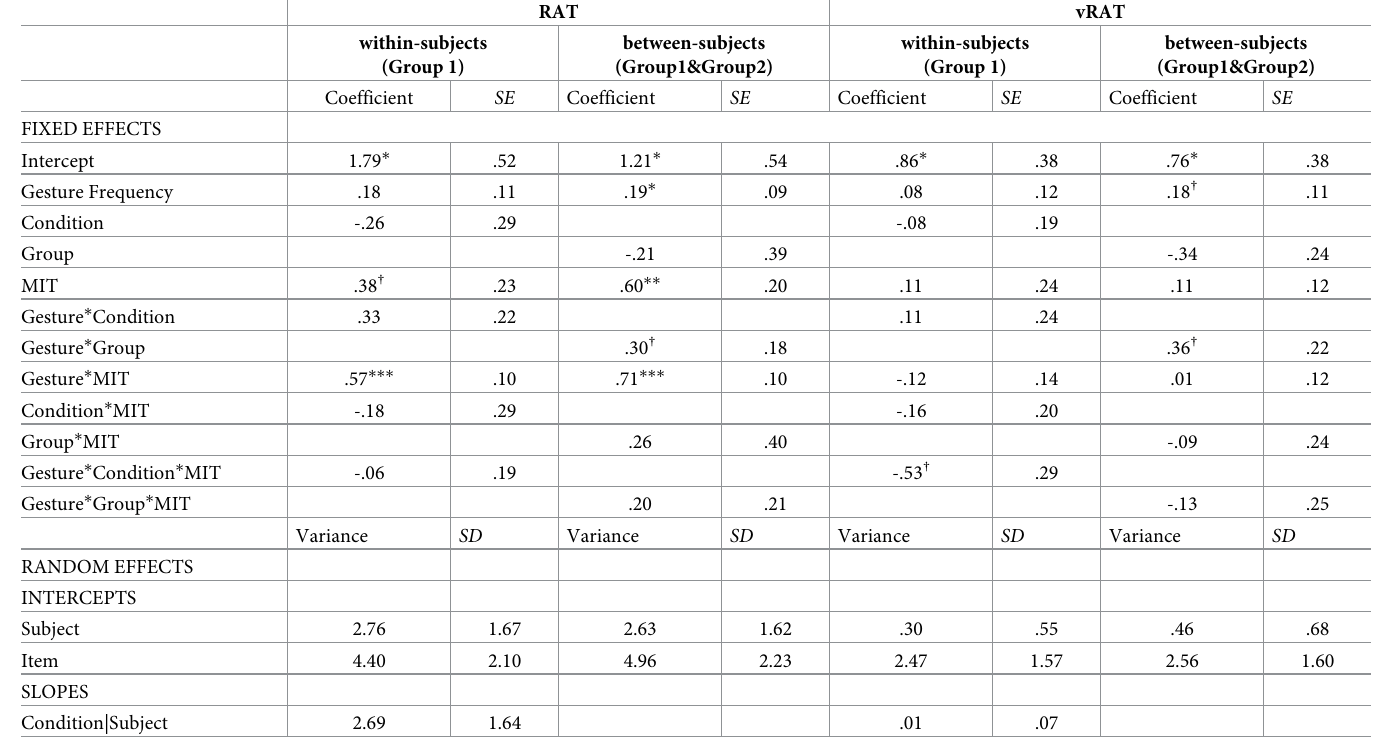
Table 3. Model summary for Hypothesis